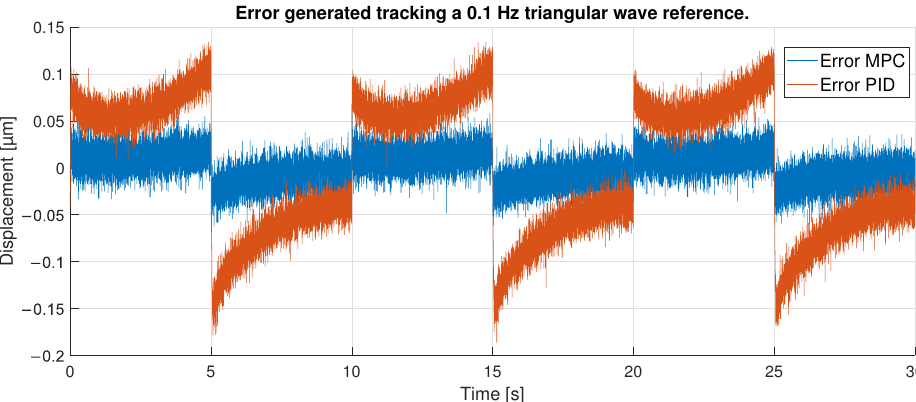
Figure 13. Error of tracking of the PID and MPC for a 0.1 Hz triangular reference.